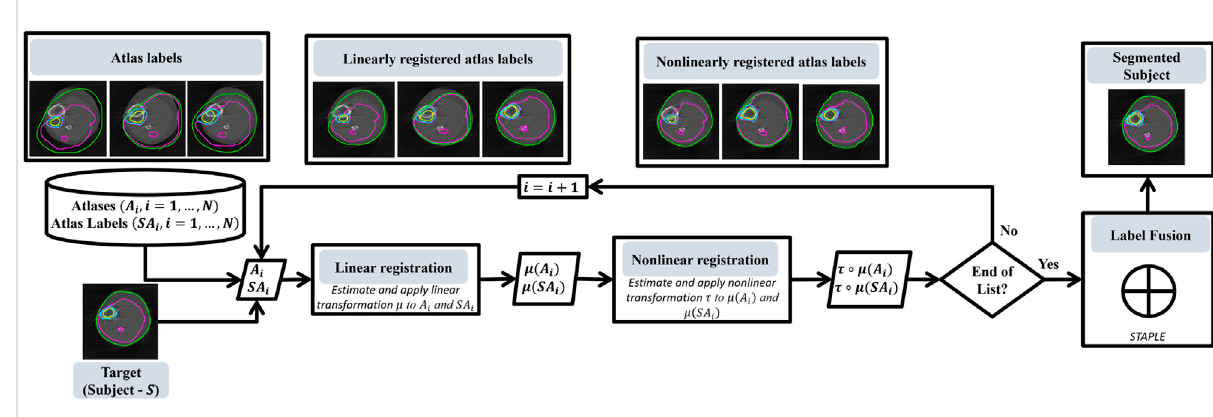
FIGURE 3 Flowchart that shows the main stages of our multi-atlas based segmentation methodology.